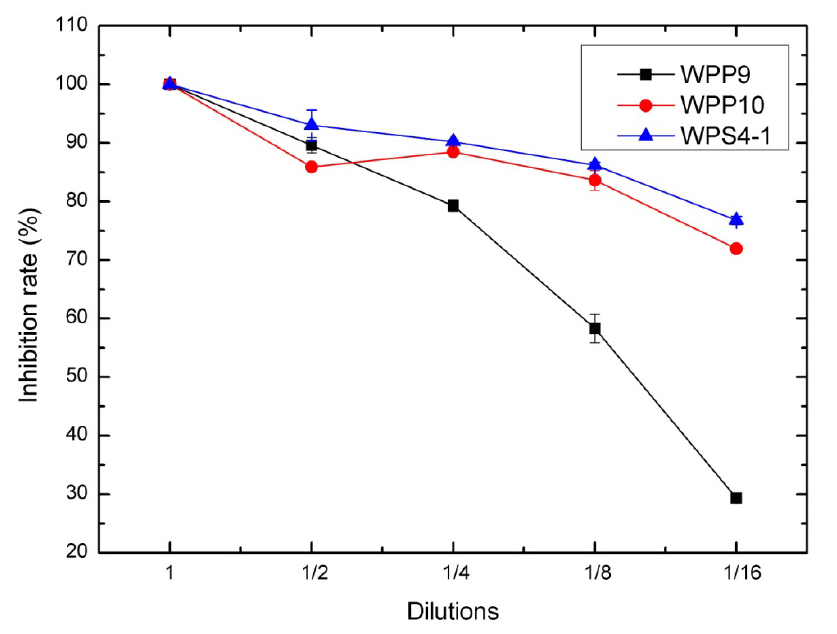
Figure 1. The inhibition of three bacterial culture supernatants with a serial dilution against F. graminearum growth in the tip-culture